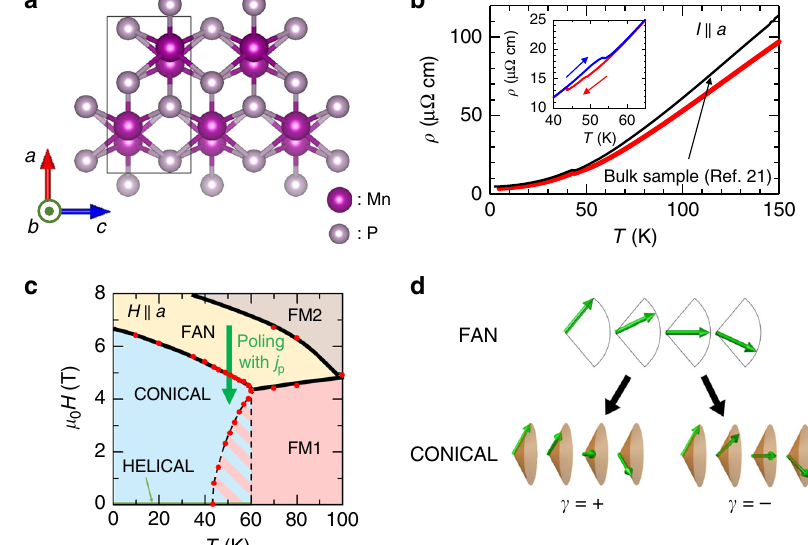
Fig. 2 Properties of the MnP sample. a Crystal structure of MnP. The black line represents the unit cell. b Temperature dependence of the resistivity for the present MnP sample fabricated by using a focused ion beam. The resistivity of a bulk (millimeter scale) sample previously measured by Shiomi et al. 21 is reproduced for comparison. The inset shows the history dependence of resistivity around the helical – ferromagnetic phase boundary. c The phase diagram of the microfabricated MnP sample for H ∣∣ a . The red dots are the phase boundaries estimated by the magnetic fi eld dependence of electrical resistivity (see Supplementary Note 2). The black lines are guides for the eyes. In the hatched region, the realized magnetic structure depends on the hysteresis. The green arrow suggests the poling procedure. d Illustrations of fan and conical magnetic